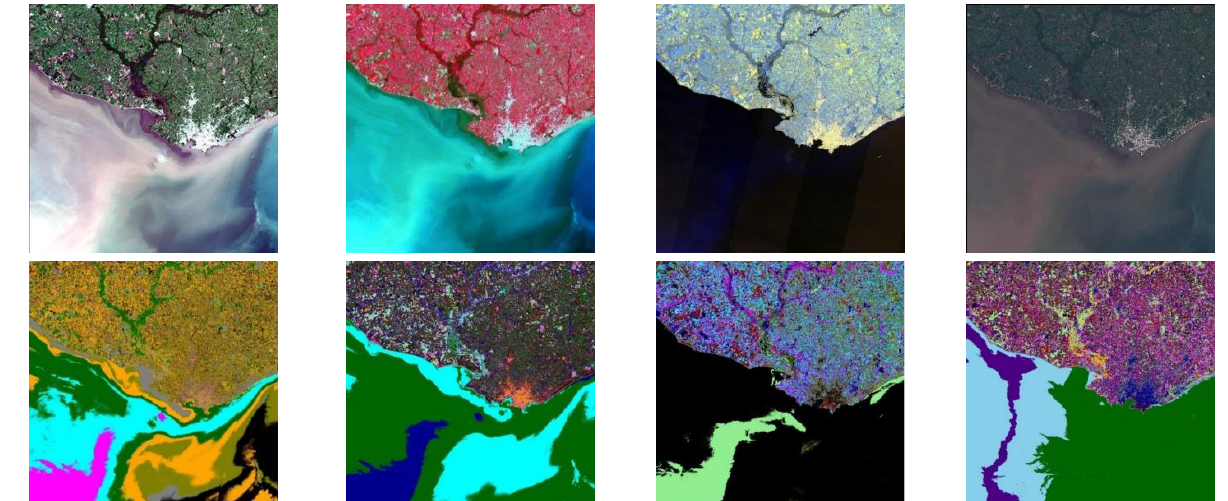
Figure 7 . The area of Montevideo, Uruguay affected by floods on October 18 th , 2019. The visibility of the different classes depends on the selection of the Sentinel-2 colour bands. (From left to right, upper part): A quick-look image of visible false-colour bands, false-colour visible/infrared bands, false-colour infrared bands, and all 13 bands. (From left to right, lower part): The topic colours are similar to Figure